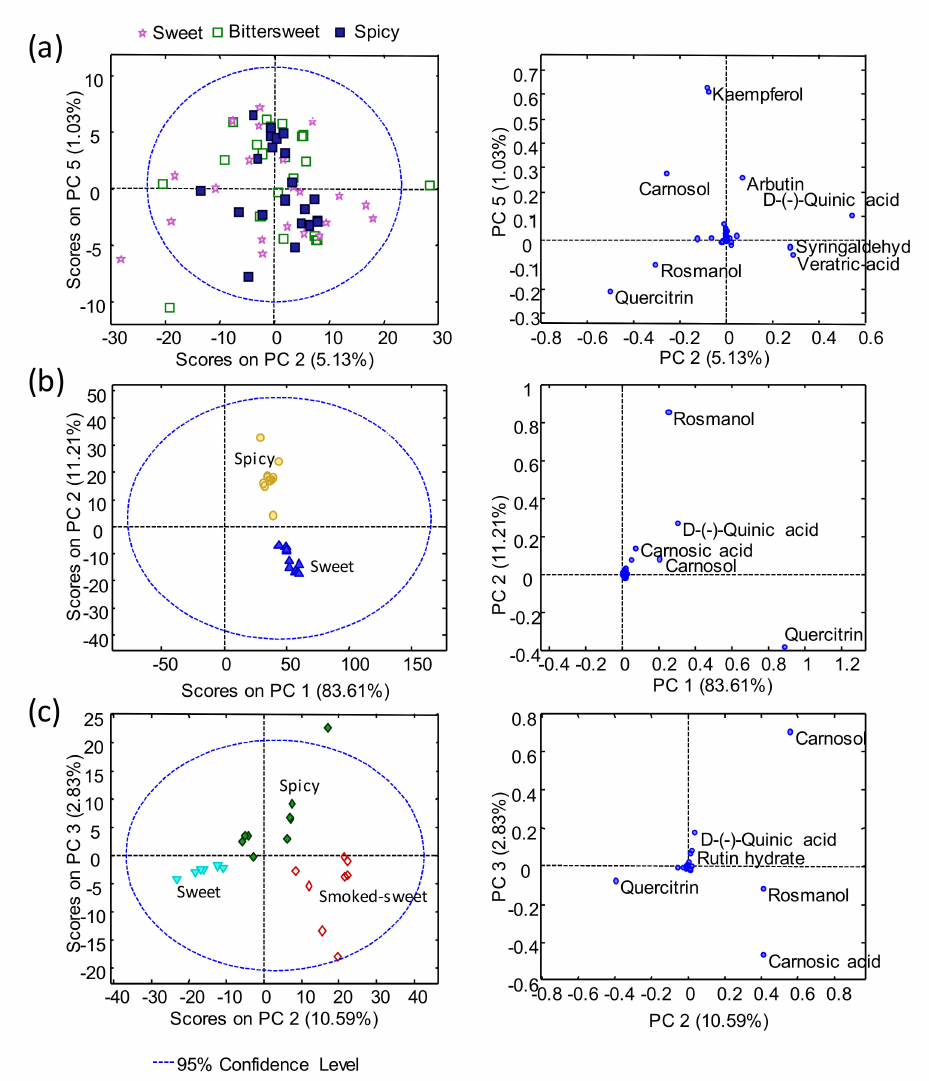
Figure 3. Principal component analysis (PCA) score and loading plots for ( a ) the La Vera PDO paprika samples, ( b ) the Murcia PDO paprika samples, and ( c ) the Czech Republic paprika